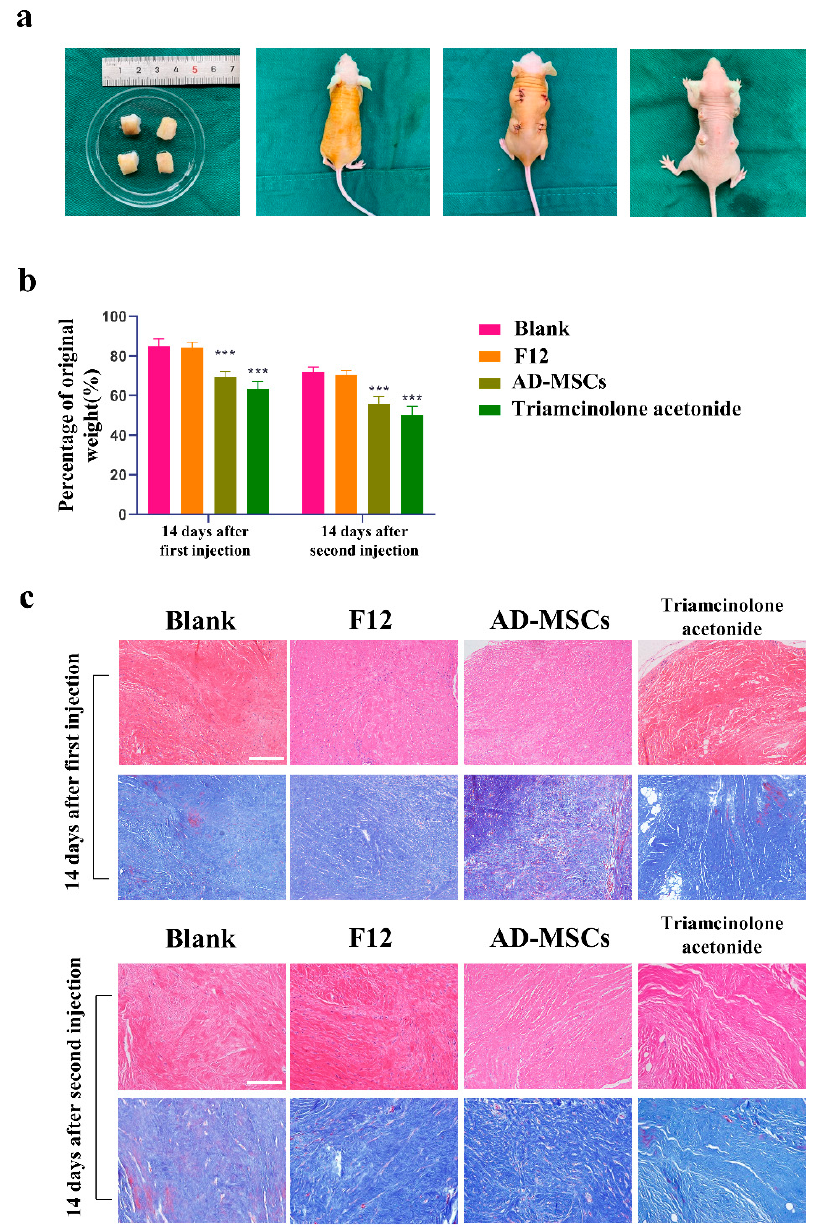
Figure 6. AD-MSCs reduced the weight of hypertrophic scar tissue transplanted in nude mice and rearranged collagen fibers. ( a ) The picture represents the process of animal model building. ( b ) Representative images show the histopathological changes and collagen deposition determined by hematoxylin and eosin and Masson’s trichrome, scale bar = 100 µ m, respectively. ( c ) The bar chart shows the weight after treatment as a percentage of the original weight (n = 6). *** p < 0.001 vs. blank group.